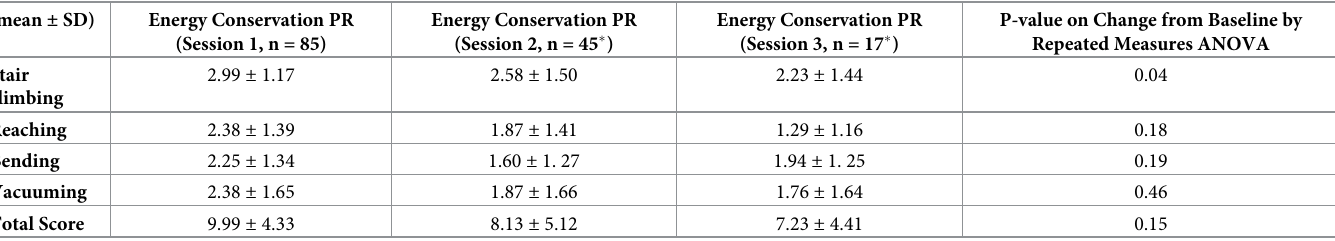
Abbreviations: PR = Pulmonary Rehabilitation. � Many patients who attended the sessions chose not to complete the follow-up